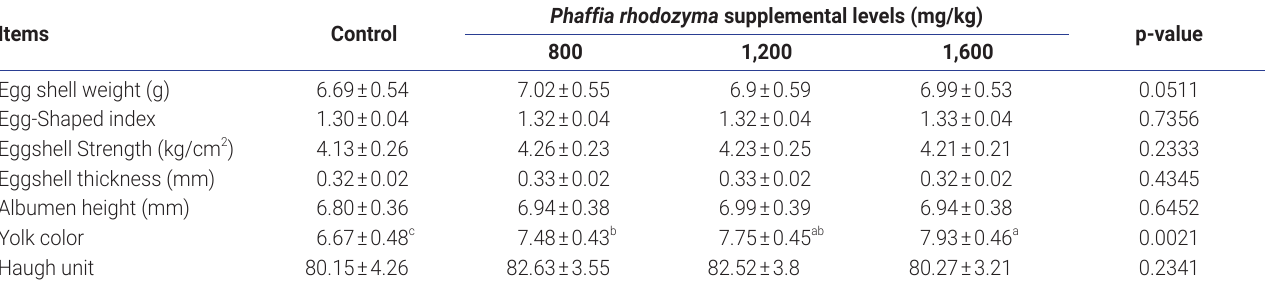
Table 3. Effect of dietary astaxanthin rich Phaffia rhodozyma levels on egg quality of laying hens